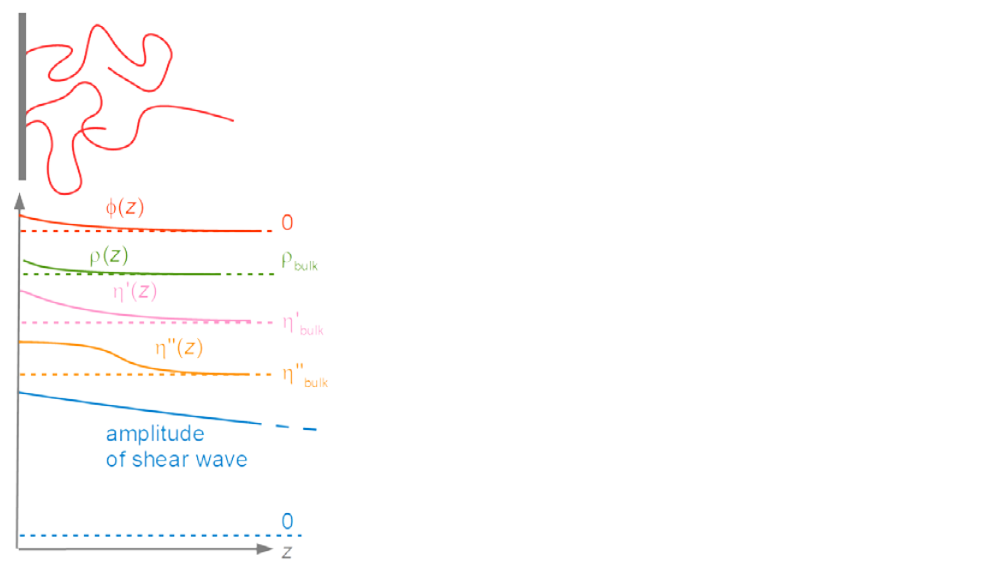
Figure 22. The frequency response induced by thin adsorbates is proportional to an integral of the response function from Equation (59). The z -range, in which ρ ( z ) and η ( z ) are significantly different from the corresponding bulk values, must be much below the depth of penetration of the shear wave, δ, in order to let the integral formulation be applicable. The displacement profile is sketched at the bottom. For most polymers, ρ ( z ) is similar to ρ bulk . The dependence of the viscosity, η ( z ) , on the polymer volume fraction, φ ( z ), is strong and not easily guessed based on simple